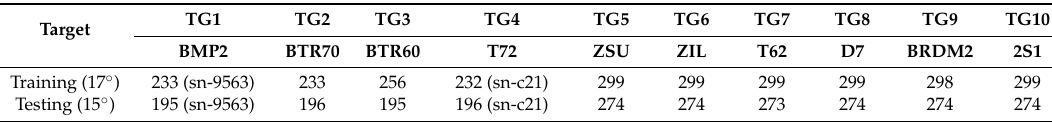
Table 2. The dataset used in multiclass experiments.